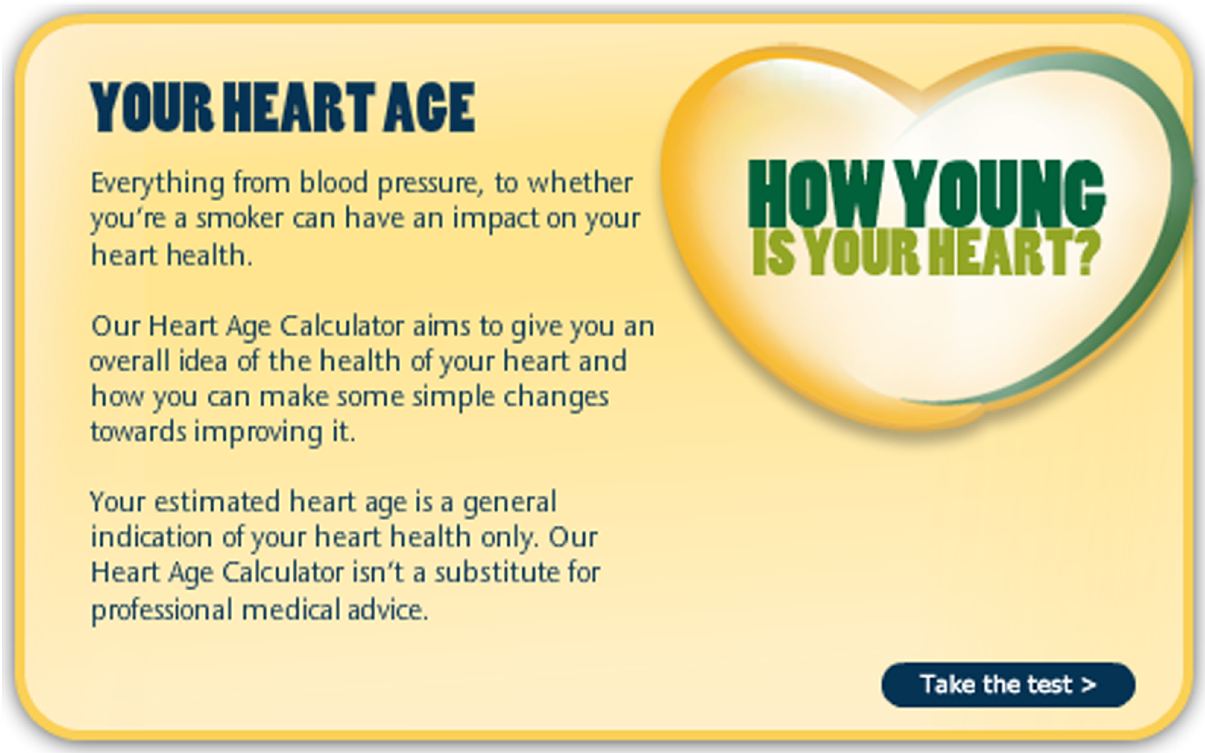
Figure 1. The Heart-Age risk